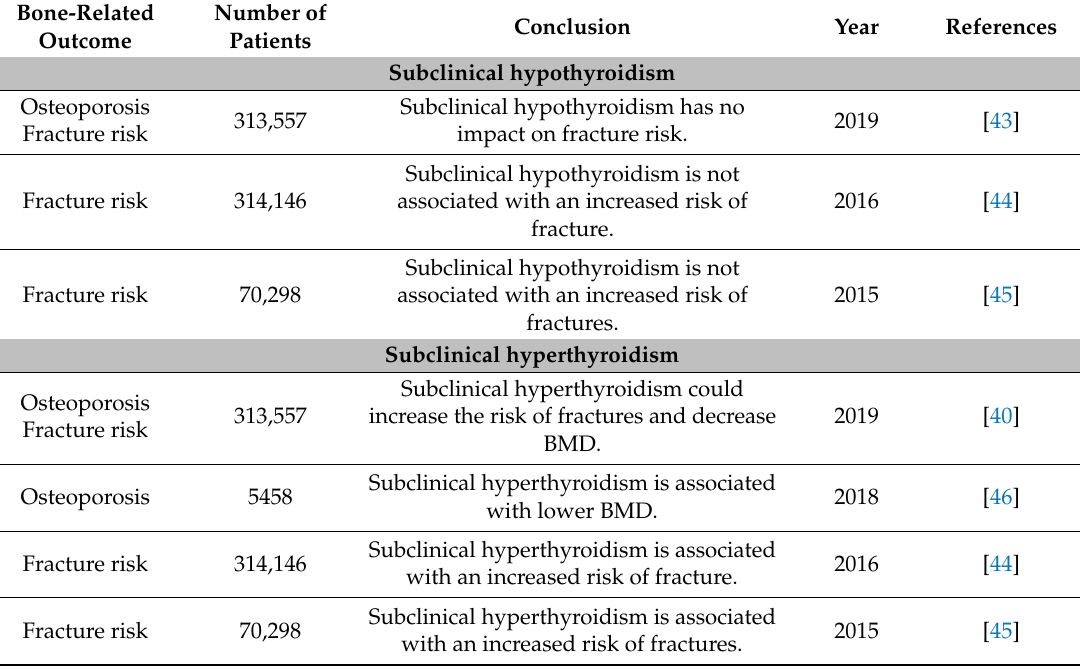
Meta-analyses regarding the impact of subclinical hypothyroidism and subclinical hyperthyroidism on bone